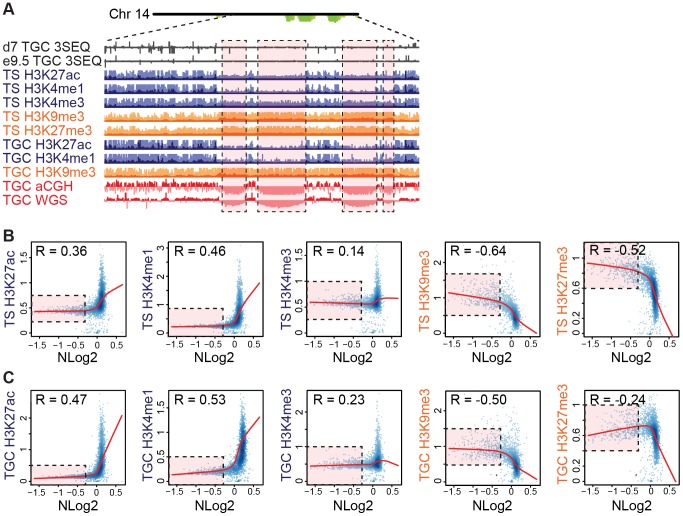
UR domains are heterochromatic.
A. UR domains correlate with histone marks. Screen shot from the UCSC genome browser of the last half of chromosome 14 (schematic shown above screen shot) showing the following: 3SEQ from in vivo e9.5 TGCs and in vitro d7 TGCs (black), active histone marks (H3K27ac, H3K4me1, H3K4me3; dark purple) and repressive histone marks (H3K9me3, H3K27me3; orange) for cultured TS cells and TGCs, and aCGH and WGS data from in vivo e9.5 TGCs (pink/red). Histone mark mean is darker color, maximum is lighter color. UR domains boxed in pink. B. UR domains are a subset of heterochromatin in TS cells. The Pearson correlation (R) between NLog2 values of TGC vs. embryo (WGS) and fold enrichment (FE) for histone marks. Data points represent 1 Mb windows in the genome. UR domains (negative NLog2 values) are correlated with high values for repressive histone marks (negative R values). UR domains (negative NLog2 values) are negatively correlated with high values for active histone marks (positive R values). Red lines represent the lowess line (locally weighted scatterplot smoothing) of the data points. UR domains boxed in pink. C. UR domains are a subset of heterochromatin in TGCs. See (B) for plot details.